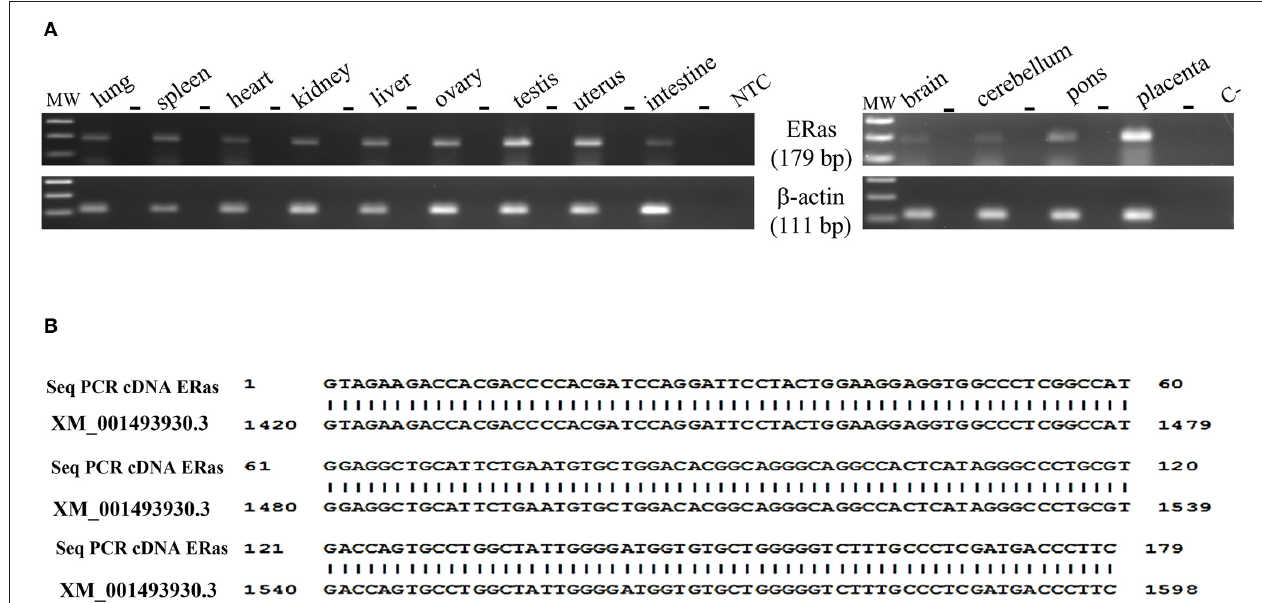
FIGURE 1 | (A) Electrophoresis of RT-PCR products for evaluating ERAS mRNA expression in equine tissues. MW: DNA molecular weight marker (100 bp). The PCR was performed both on samples in which reverse transcriptase (RT) was added to the reaction mix and in those without RT (-), using the same amount of RNA. NTC: